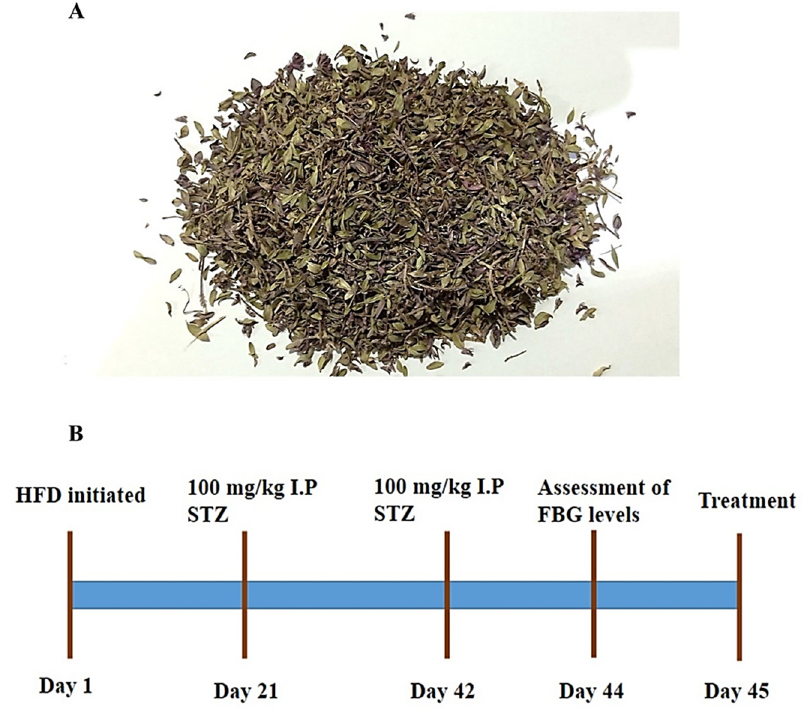
Figure 1. ( A ) Image of the Thymus serpyllum, harvested for the present study. ( B ) Timeline depicting the diabetic mice model construction. HFD: High-fat diet; STZ: Streptozotocin; FBG: Fasting blood glucose.